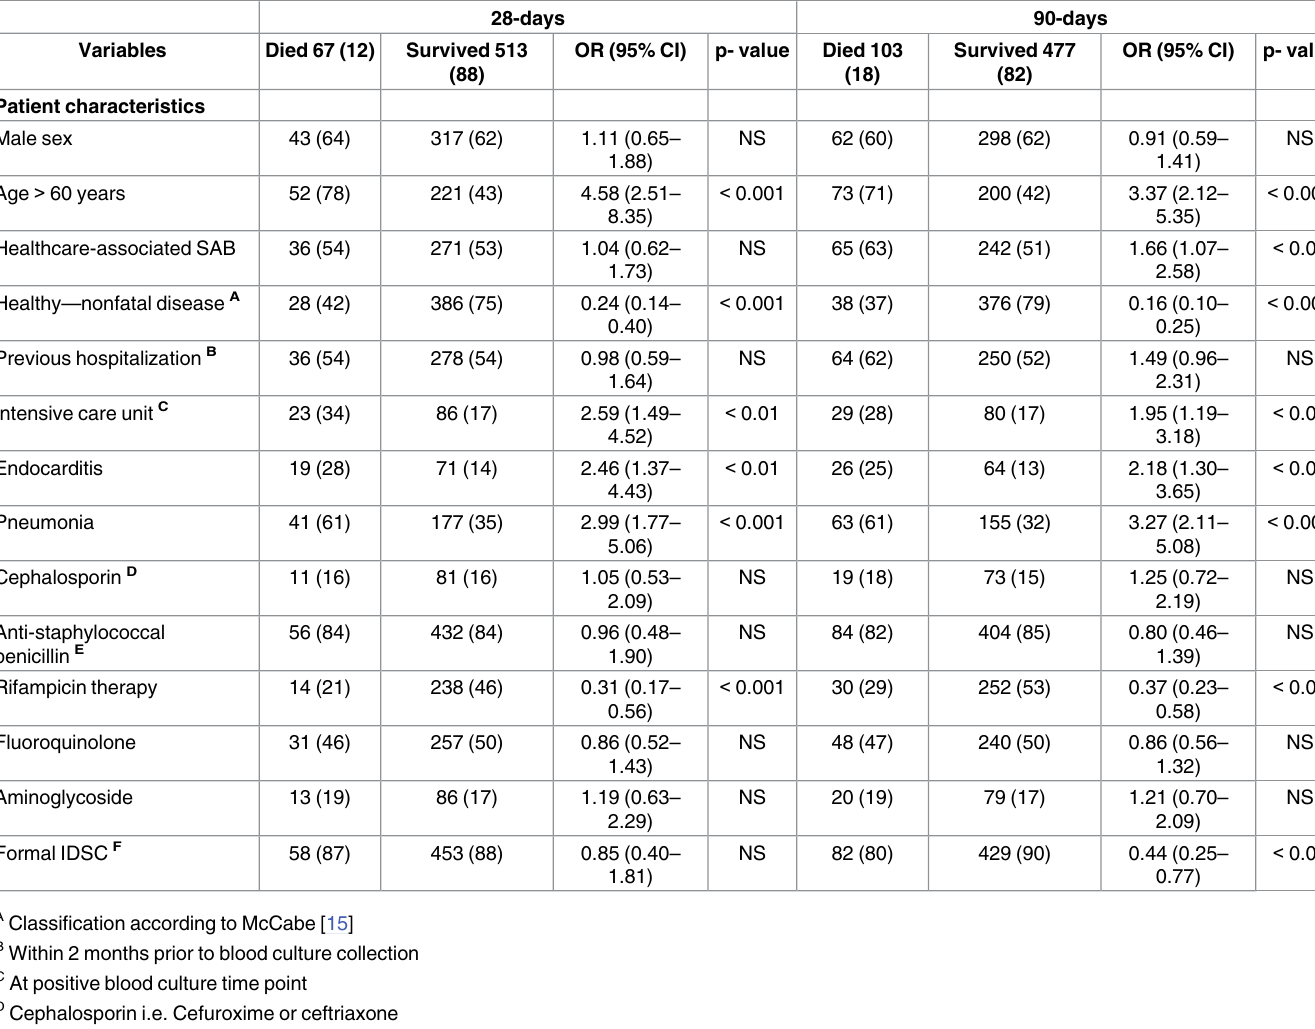
Table 2. Univariate analysis of prognostic factors for 28- and 90-days mortality in 580 patients with methicillin-sensitive Staphylococcus aureus bacteremia. Values are expressedas N (%). NS =